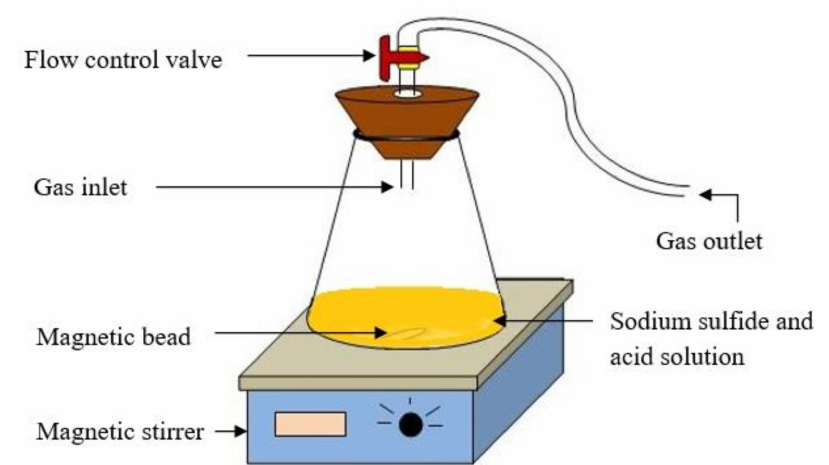
Figure 12. Schematic diagram of set-up used for H 2 S gas